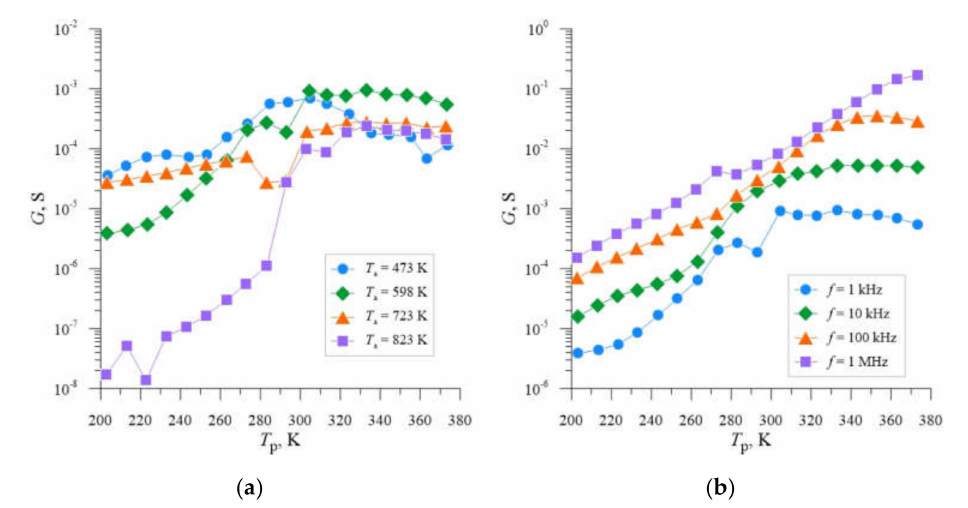
Figure 4. Dependencies G = f( T p ) for silicon with resistivity ρ = 0.4 Ω cm, boron-doped, implanted with Ne + neon ions with energy E = 100 keV and dose D = 2.2 × 10 14 cm − 2 , determined for the frequency f = 1 kHz and four different annealing temperatures T a ( a ) and annealing temperature T a = 598 K and four different measurement frequencies f ( b